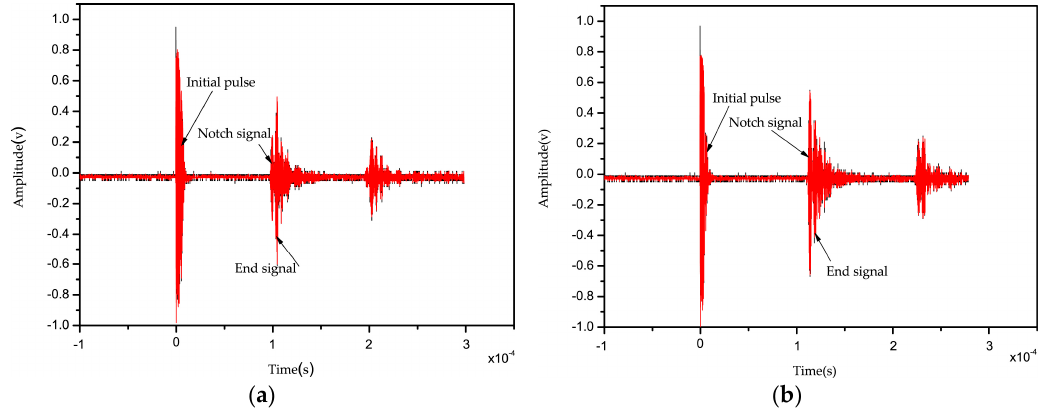
Figure 4. Notch depth with ( a ) 0.1 mm; ( b ) 0.3 mm notch signal amplitude.